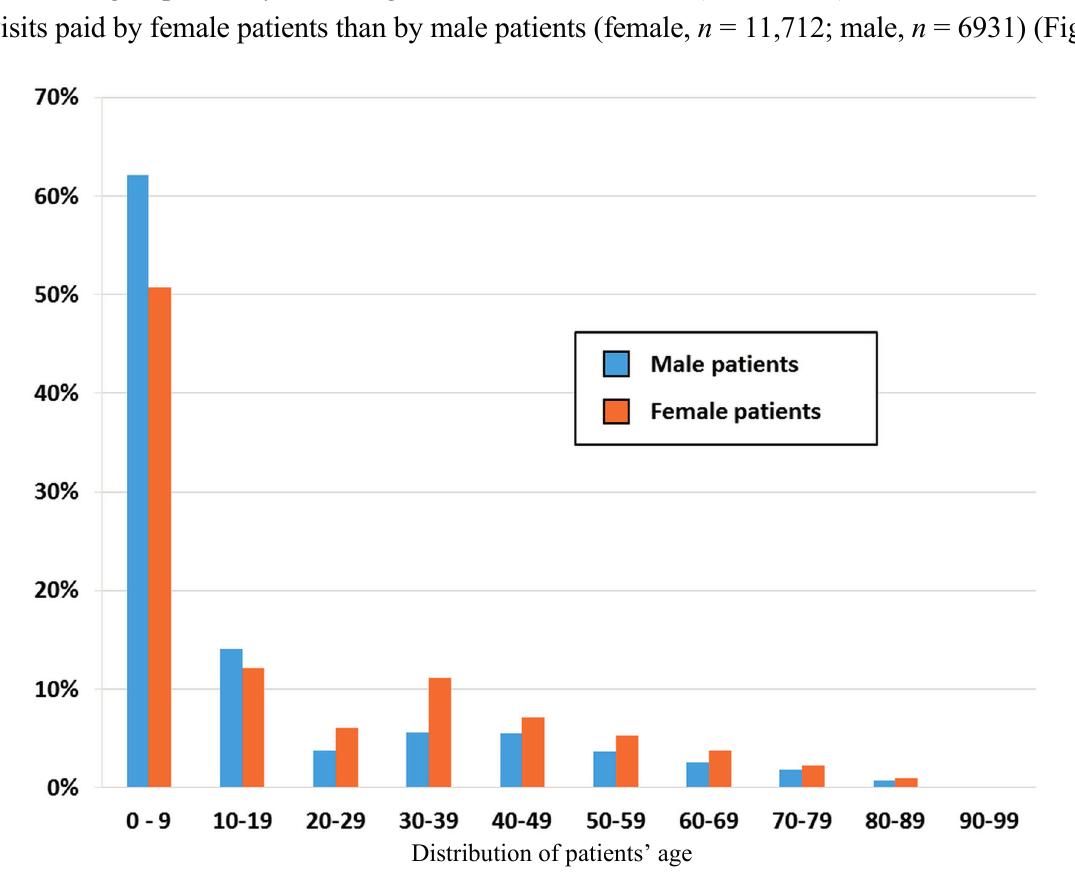
Figure 1. Age and sex distribution of the patients who visited pediatricians, data from Taiwan’s National Health Insurance in 2012 (sampling rate: